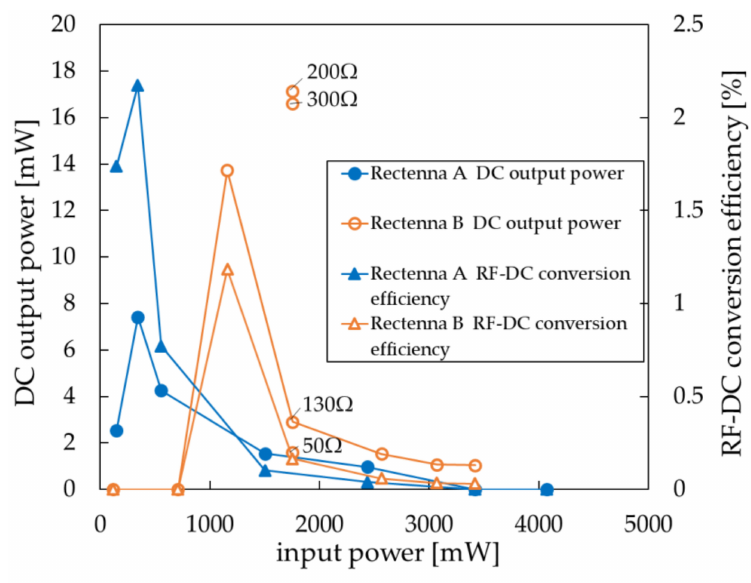
Figure 22. Measurement results of 303 GHz DC output power and RF–DC conversion efficiency (line shows result at 130 Ω